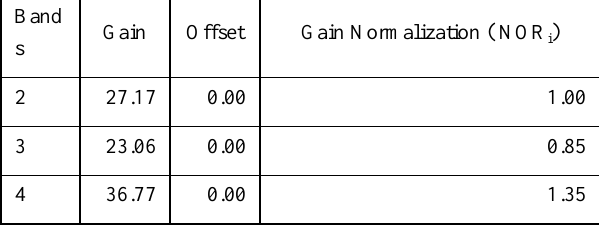
The calculation of Final Predicted Haze Values (FPHV) is done